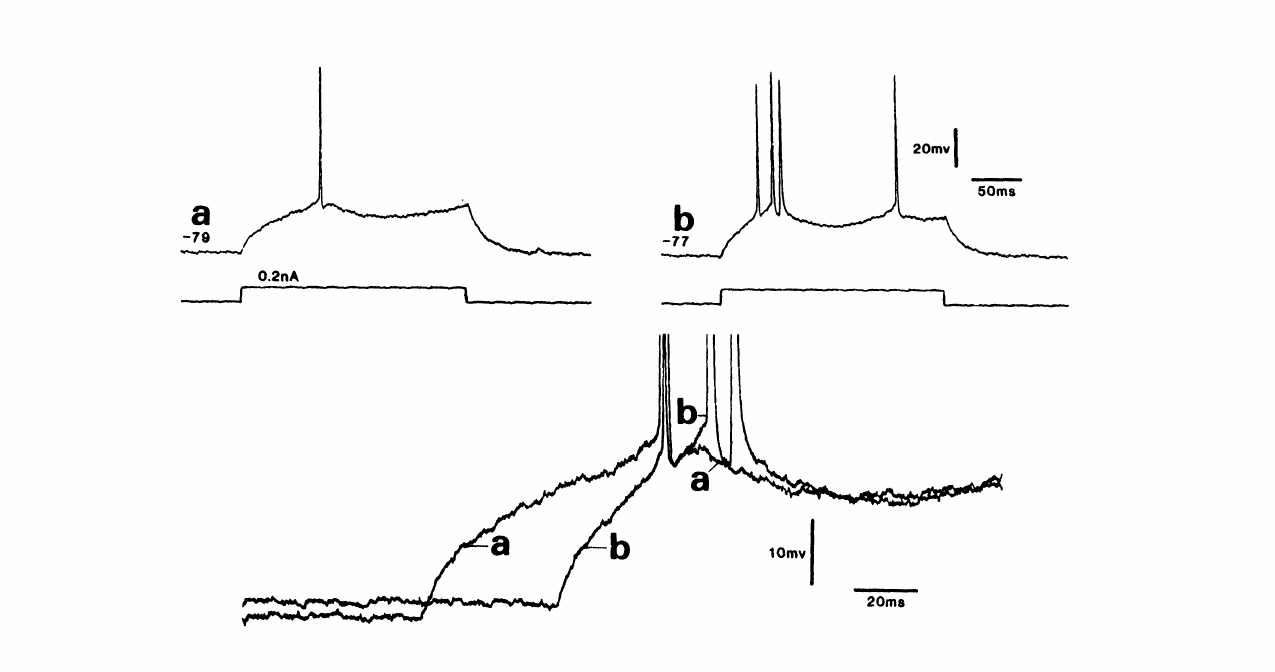
Fig. 5: Norepinephrine (10 tM) promotes burst appearance in nonbursting cells. Response to suprathreshold (0.2nA) intracellular depolarizing current pulse for eliciting a single AP in control (a) and during norepinephrine-induced depolarization (b). Bottom: superimposition of enlarged records a and b, taking the fast hyperpolarization peak as a